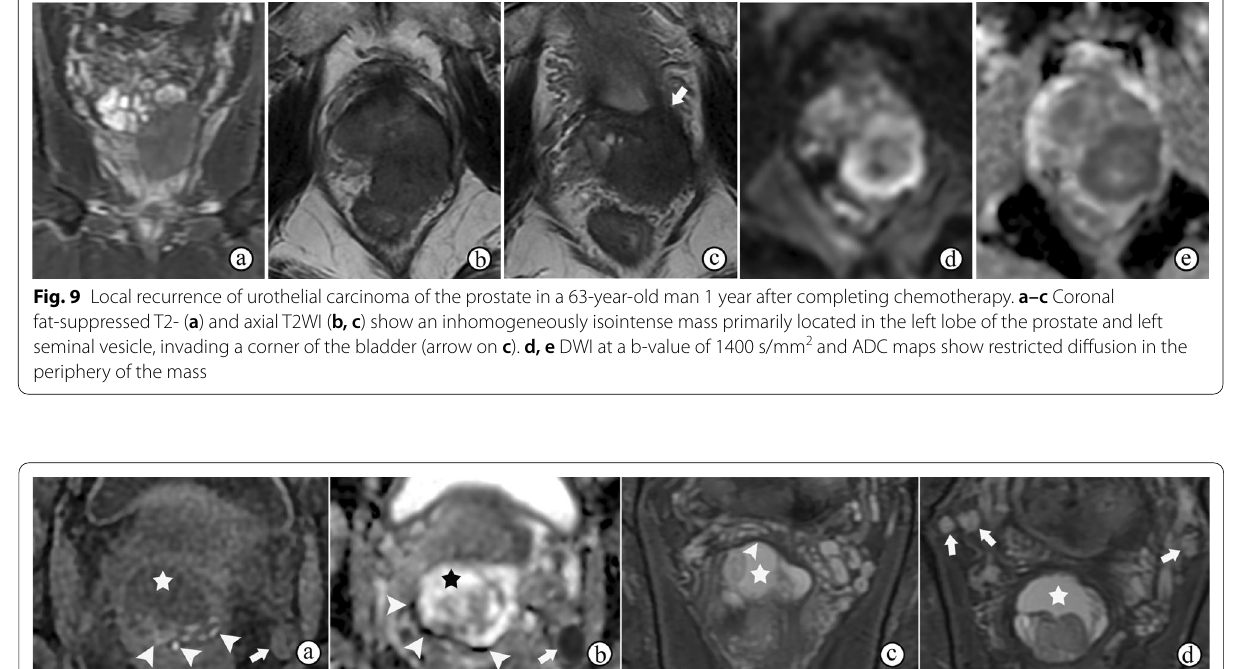
Fig. 10 Prostatic stromal sarcoma in a 49-year-old man with a mildly elevated serum PSA level of 7.5 ng/mL. a–c Axial fat-suppressed T1WI, ADC maps and T2WI show a mass containing solid and necrotic components ( ☆ ). The high signal intensity area on axial fat-suppressed T1WI ( a ) and the low signal intensity area on ADC maps ( b ) both suggest a hemorrhagic change (arrowhead). c Coronal fat-suppressed T2WI shows an incomplete capsule around the mass and the right seminal vesicle compressed by the mass (arrowhead). b, d ADC maps and coronal fat-suppressed T2WI show enlarged pelvic lymph nodes (arrow)